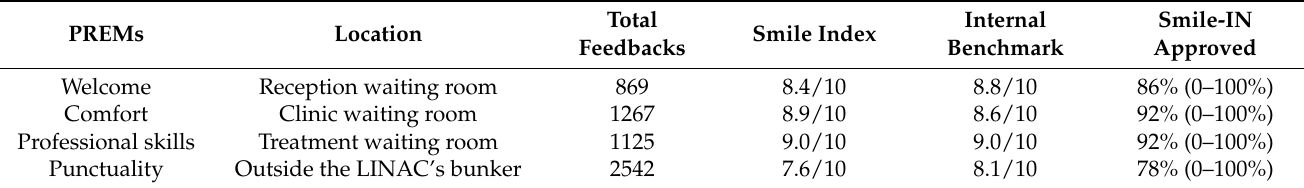
Table 1. Overall collected feedbacks and related indexes during the observational period (February